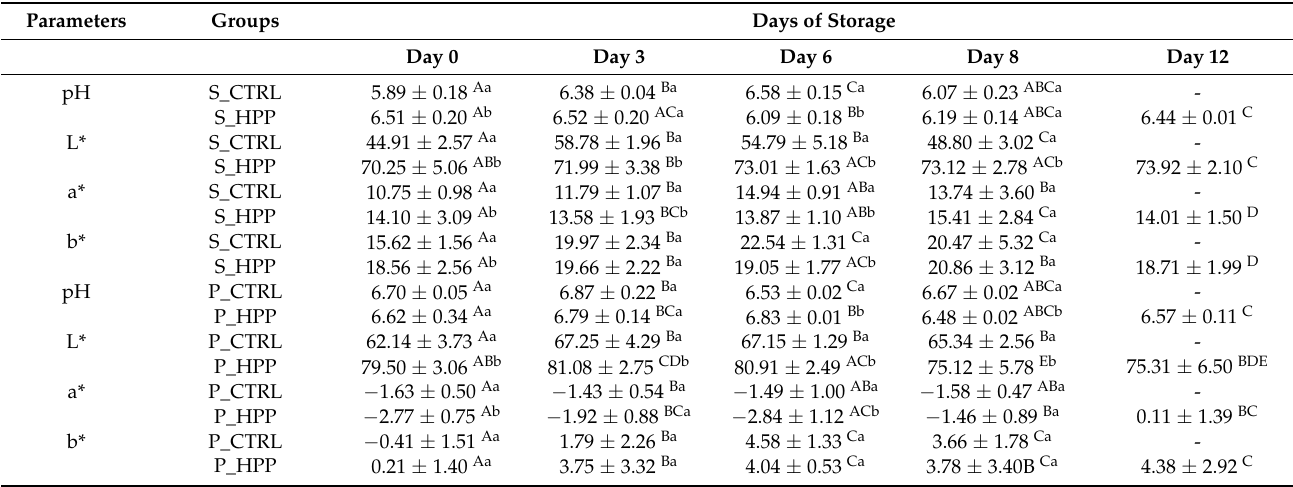
Table 2. Effect of high-pressure treatment on pH and color parameters on salmon (S_CTRL and S_HPP) and plaice (P_CTRL and P_HPP) fillets at different storage days (mean ± standard